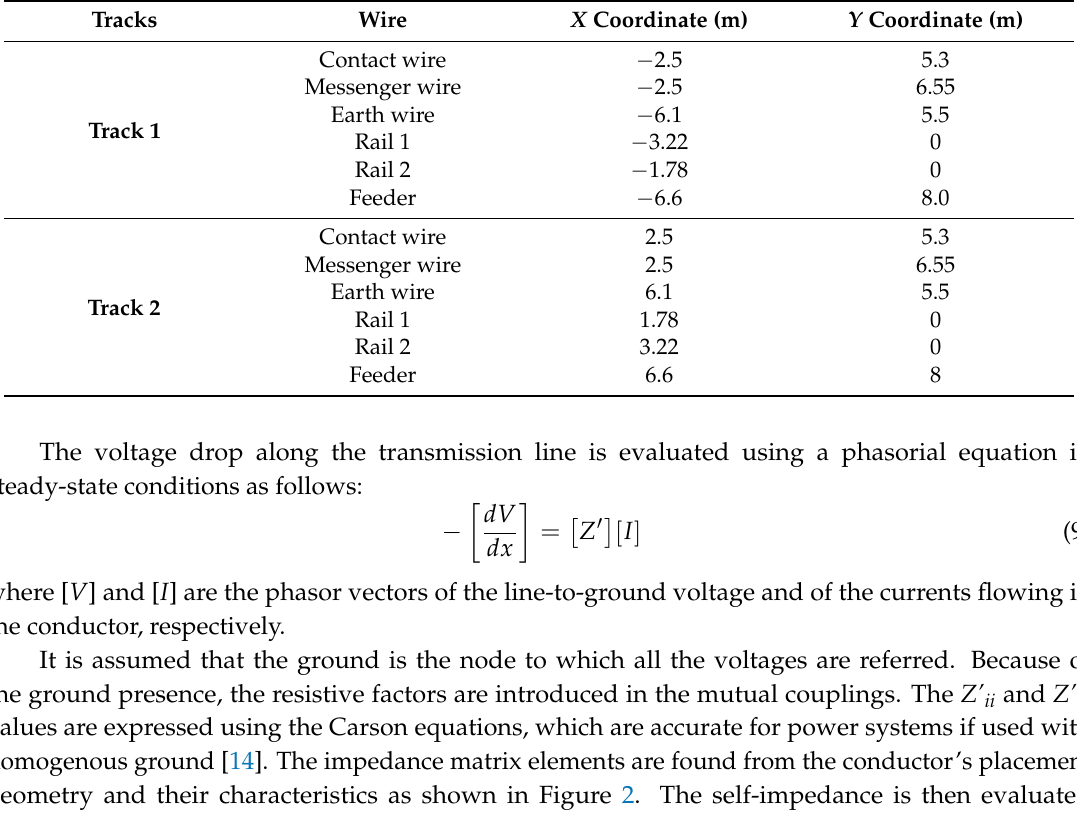
Table 2. Wires and rail positions on an Italian high-speed line built on an embankment.